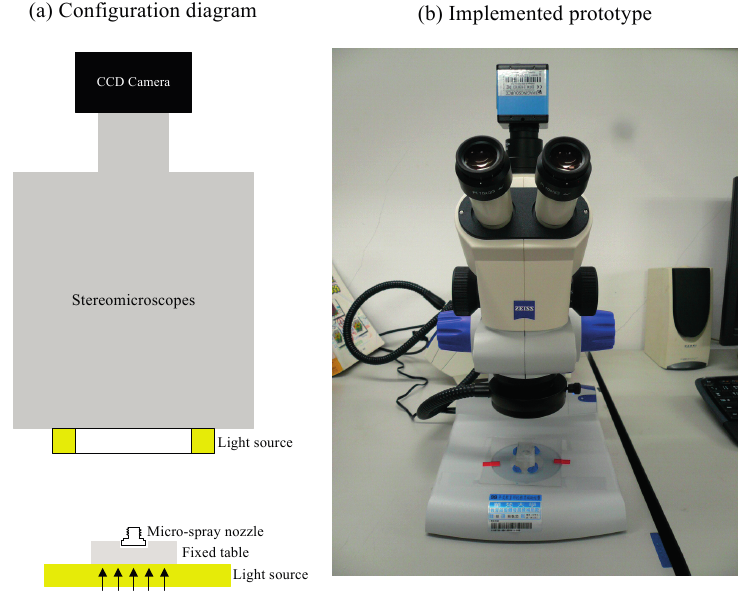
Figure 4. Illustration of the machine vision system for micro-spray nozzle defect